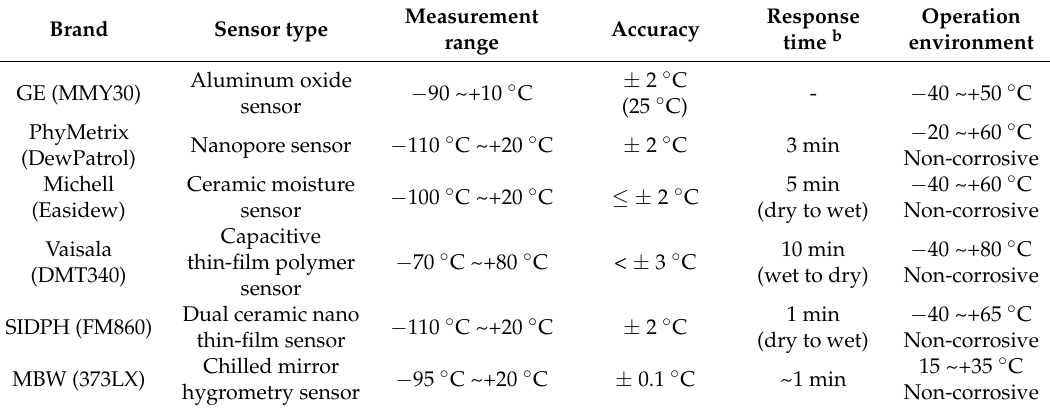
Table 1. Brands and some parameters of several commercially available dew/frost point instruments a